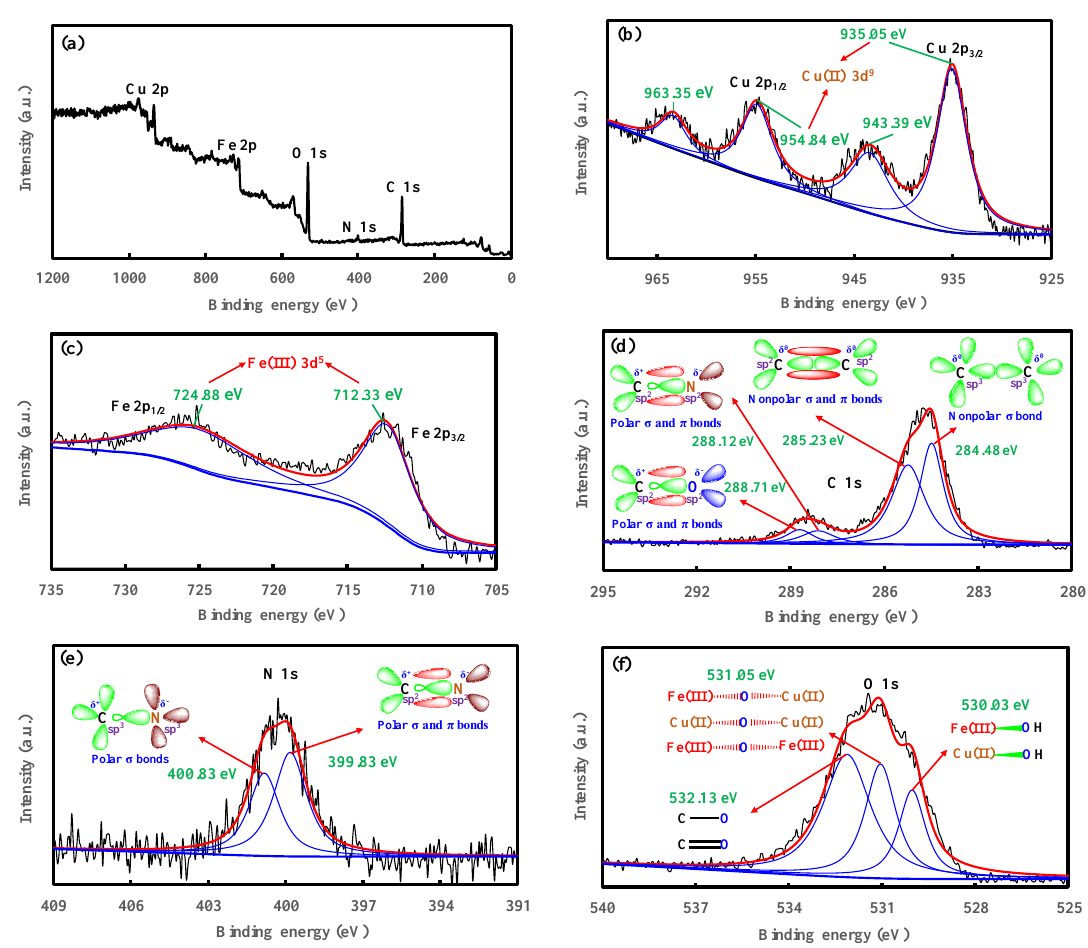
Figure 3. ( a ) Full-range XPS spectra of CuFe-LDH/N-CQDs. ( b ) XPS peaks for Cu 2p. ( c ) XPS peaks for Fe 2p. ( d ) XPS peaks for C 1s. ( e ) XPS peaks for N 1s. ( f ) XPS peaks for O 1s.